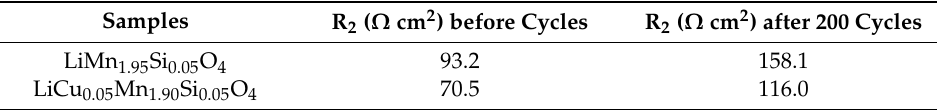
Figure 6. Nyquist plots of the LiMn 1.95 Si 0.05 O 4 ( a ) and LiCu 0.05 Mn 1.90 Si 0.05 O 4 ( b ) samples before cycling and after 200 cycles; ( c ) Equivalent circuit model of EIS. Table 2. Fitting values of the charge transfer resistance (R 2 ) calculated from EIS.